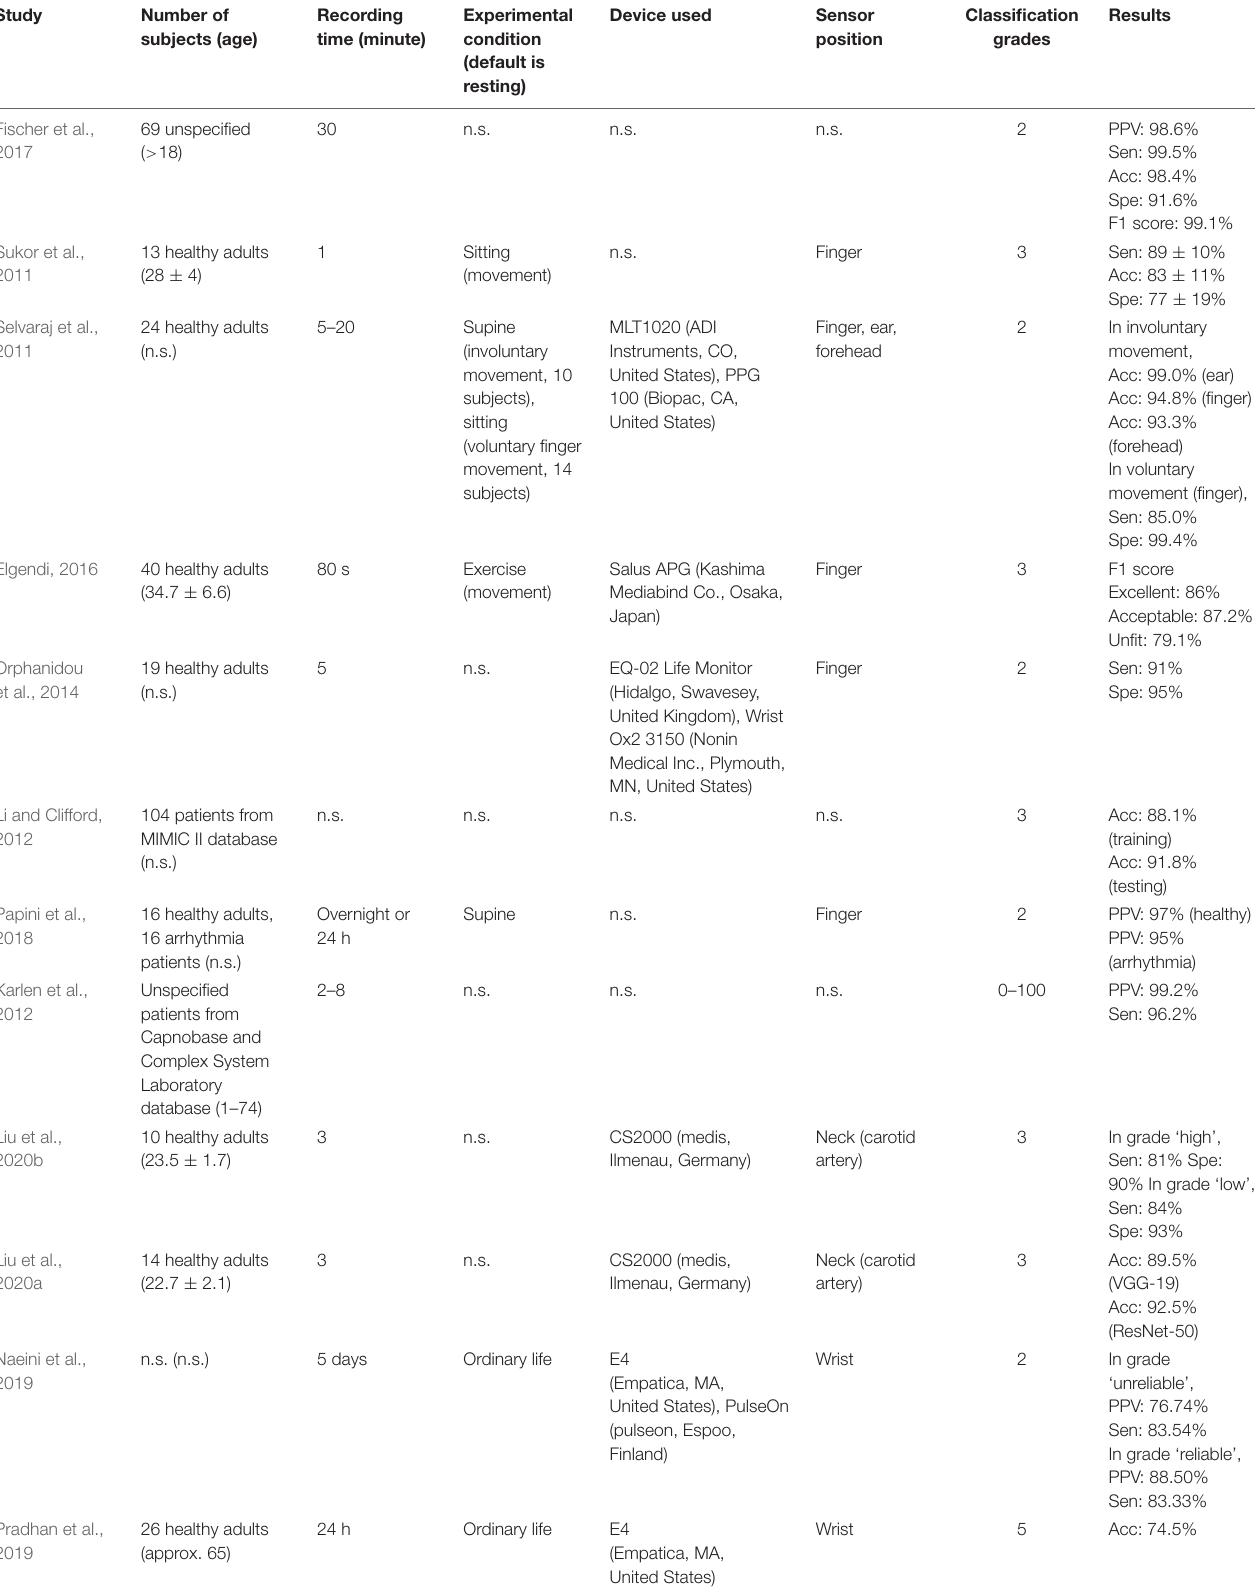
TABLE 4 | Overview of studies on PPG signal quality